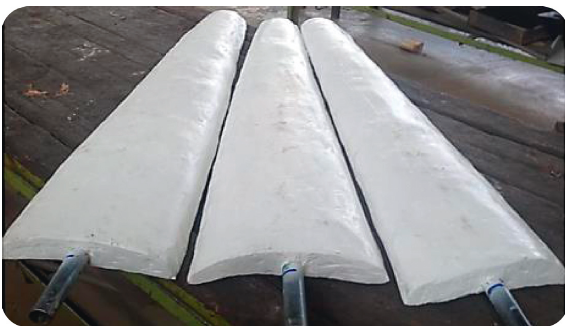
Figure 3: Styrofoam blade element cross sections. Figure